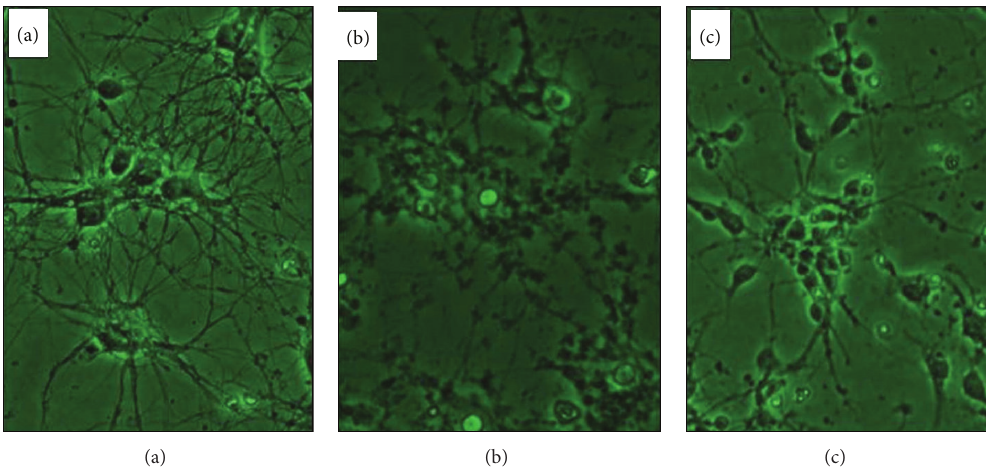
Figure 1: High magnification ( × 400) photomicrographs of cultured embryonic cortical neuronal cells from 14- to 16-day-old rats ( in vitro ); normal group (untreated). The nuclear membranes are distinct, and the dendrocyte is normal [1]. Glu-[350 𝜇 M for 20min in Mg 2+ -free EBBS and incubated for 20–24 h at 37 ∘ C in MEM supplemented with glucose] treated group, showing cellular swelling; dendrocyte is breaking and the nuclear shape is indistinct [2]. Glutamate-treated group in presence of S. baicalensis (100 𝜇 g/mL) extract and maintained as above [3]; note that the cellular shape is generally regular almost like that of untreated